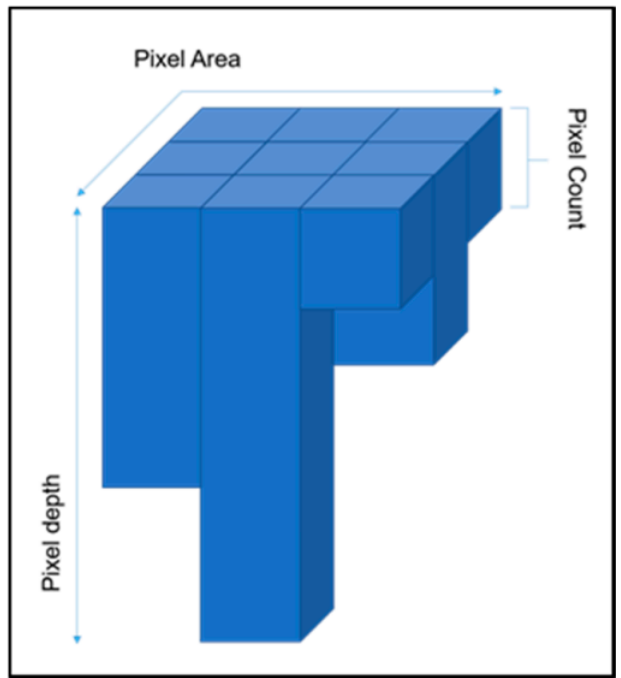
Figure 4. Schematic representation of a Blue